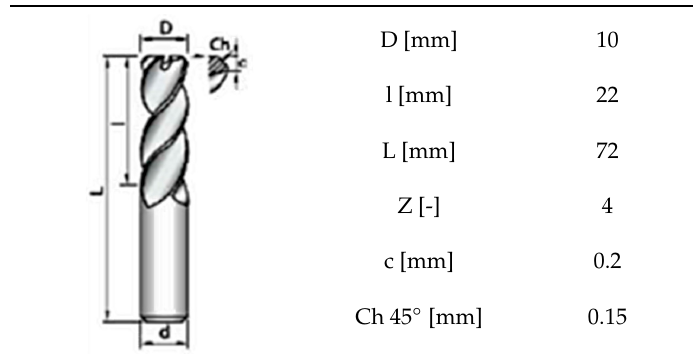
Table 2. Characteristics of the endmill.